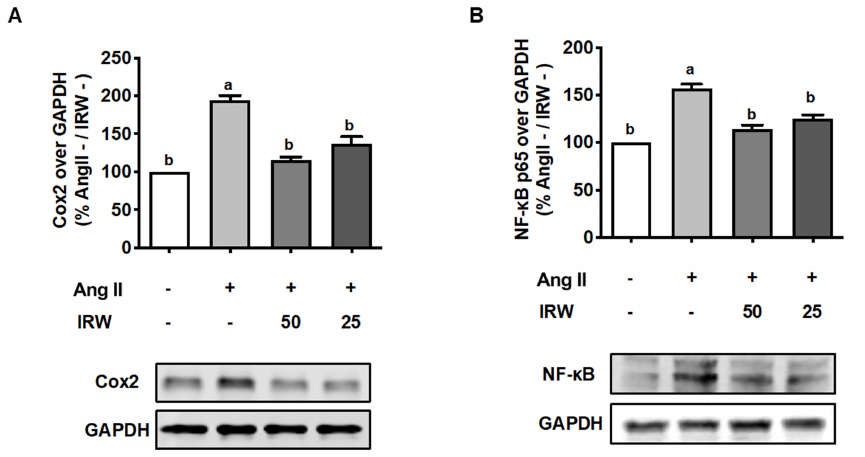
Figure 4. The effect of IRW on Cox2 and NF- κ B p65 with Ang II stimulation. Osteoblast cells MC3T3- E1 were pre-treated with IRW (50 μ M and 25 μ M) for 2 h prior to Ang II (1 μ M) and then co-cultured for 24 h. Whole cell lysates were collected and used for the Western blotting analysis to measure the protein expression of ( A ) cyclooxygenase-2 (Cox2) and ( B ) NF- κ B p65. All results are representative of 6 independent experiments and expressed as mean ± SEM. Mean without a common letter indi- cated p < 0.05. 3.5. IRW Mitigates Cellular Stress Induced by Ang II in AT2R Dependent Manner in Bone Cells In order to understand the underlying mechanisms supporting the osteogenic/cyto- protective role of IRW, the expression of vital protective RAAS receptors AT2R and MasR was inhibited using their specific inhibitions in the presence and absence of IRW (50 μ M). The use of MasRi (A779, 1 μ M) and AT2Ri (PD123319, 1 μ M) efficiently inhibited MasR and AT2R, respectively, in MC3T3-E1 cells ( p < 0.01) (Figure 4A,B). Next, our results showed that IRW treatment (50 μ M) exhibited a significant increase in RUNX2, a vital factor for osteoblast proliferation, in presence of MasRi (A779, 1 μ M). However, in pres- ence of AT2Ri (PD123319, 1 μ M), the ability of IRW to increase RUNX2 was diminished in MC3T3-E1 cells ( p < 0.05) (Figure 5B,D).